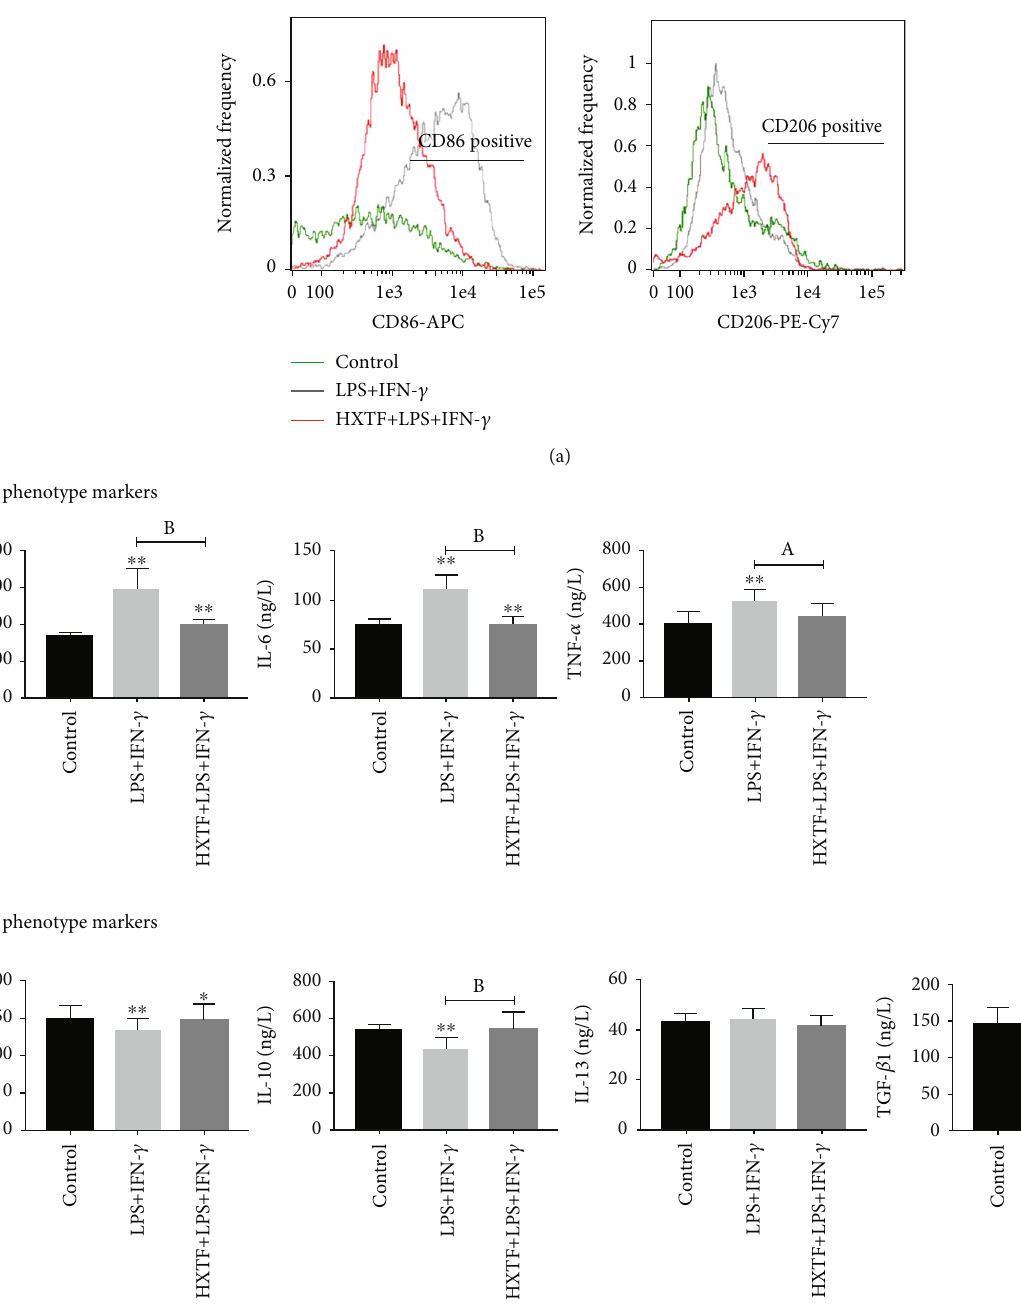
Figure 8(b); the sham group (median, 0.00; IQR, 0.00-